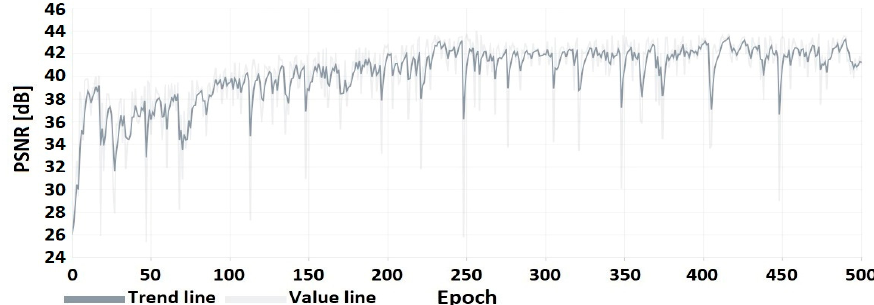
Figure 8. PSNR of the embedded watermarked image relative to the original image.